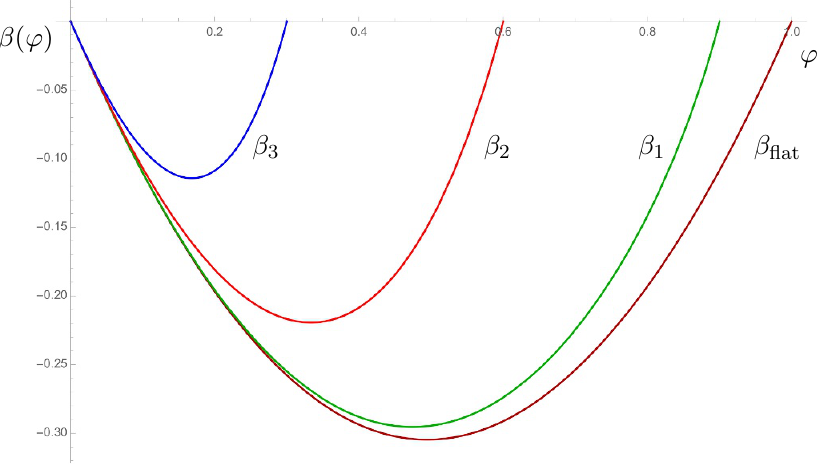
Figure 17. Solutions for (cid:12) ( ’ ) = (cid:0) 2( d (cid:0) 1) S ( ’ ) with R (cid:21) 0 and for the potential (5.1) with W ( ’ ) (cid:1) (cid:0) = 1 : 2. The (cid:12)ve solutions (cid:12) i ( ’ ) with i = 1 ; : : : ; 5 di(cid:11)er in the value of their IR endpoint ’ 0 .